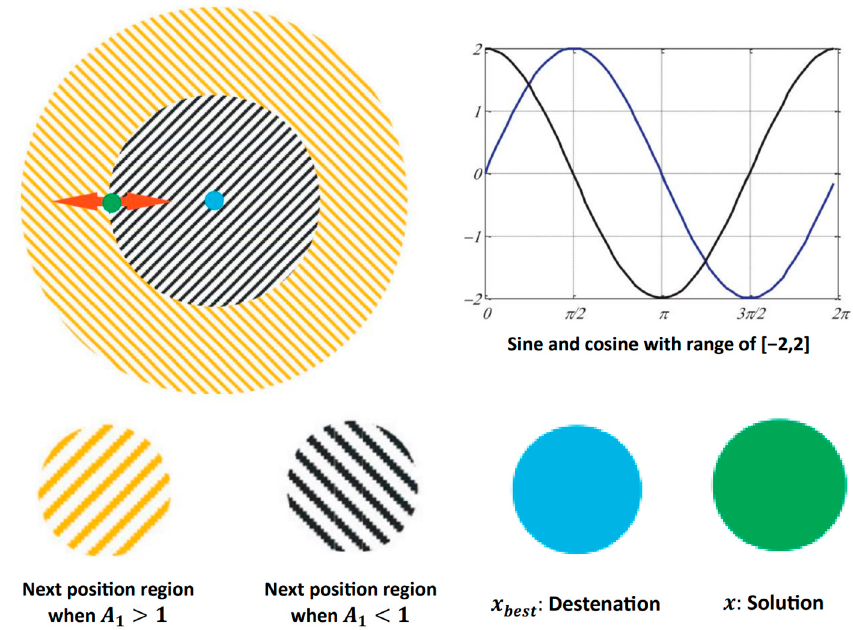
Figure 2. The procedure for updating in terms of sine and cosine functions with a [ 2, 2 ] range [31].